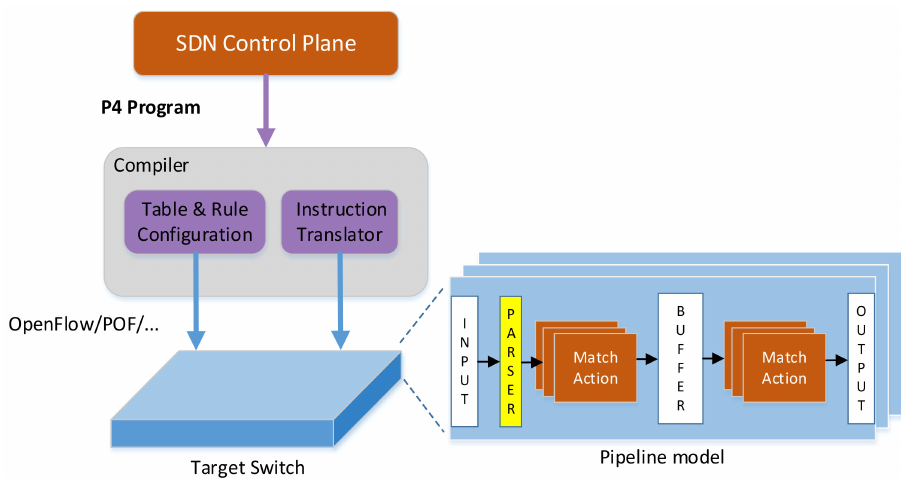
Figure 2. P4 is a network programming